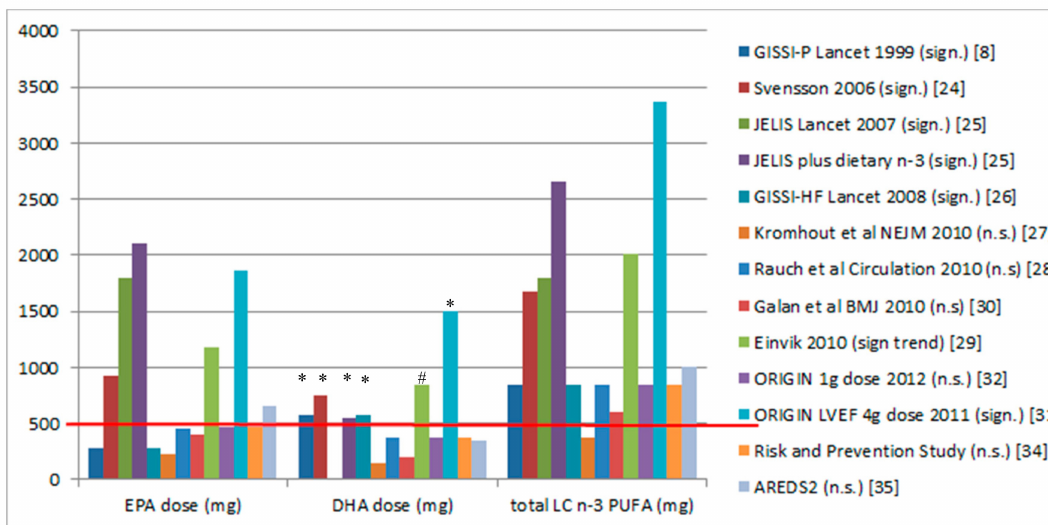
Figure 1. Doses of eicosapentaenoic acid (EPA), docosahexaenoic acid (DHA), and total omega-3 long-chain polyunsaturated fatty acid ( n -3 LCPUFA) from randomised controlled trials on n -3 LCPUFA supplementation and clinical cardiovascular disease (CVD) outcomes. The red line shows that a DHA dose of 500 mg or greater results in significant CVD outcomes. * Significant effects ( p < 0.05); # only 140 per group showing a trend towards a significant effect ( p = 0.063). Sign means significant and n.s. means not